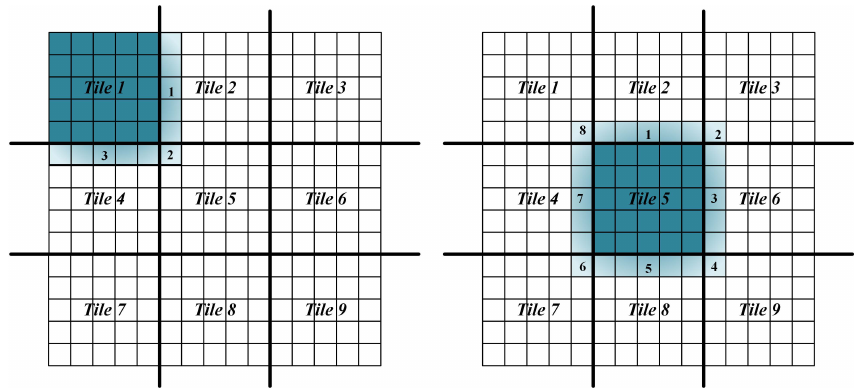
Figure 11. The halo